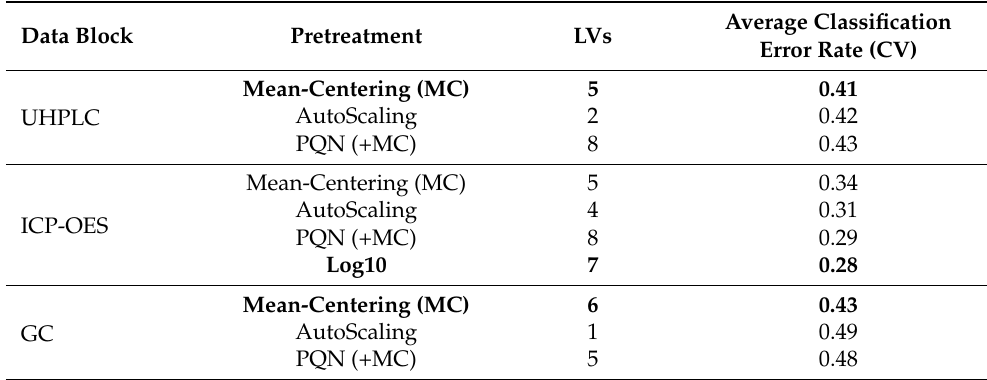
Table 2. PLS-DA models on the individual UHPLC, ICP-OES and GC data blocks with related number of latent variables (LVs). Average classification error rates are calculated in a 5-fold cross-validation (CV). Optimal calibration models are